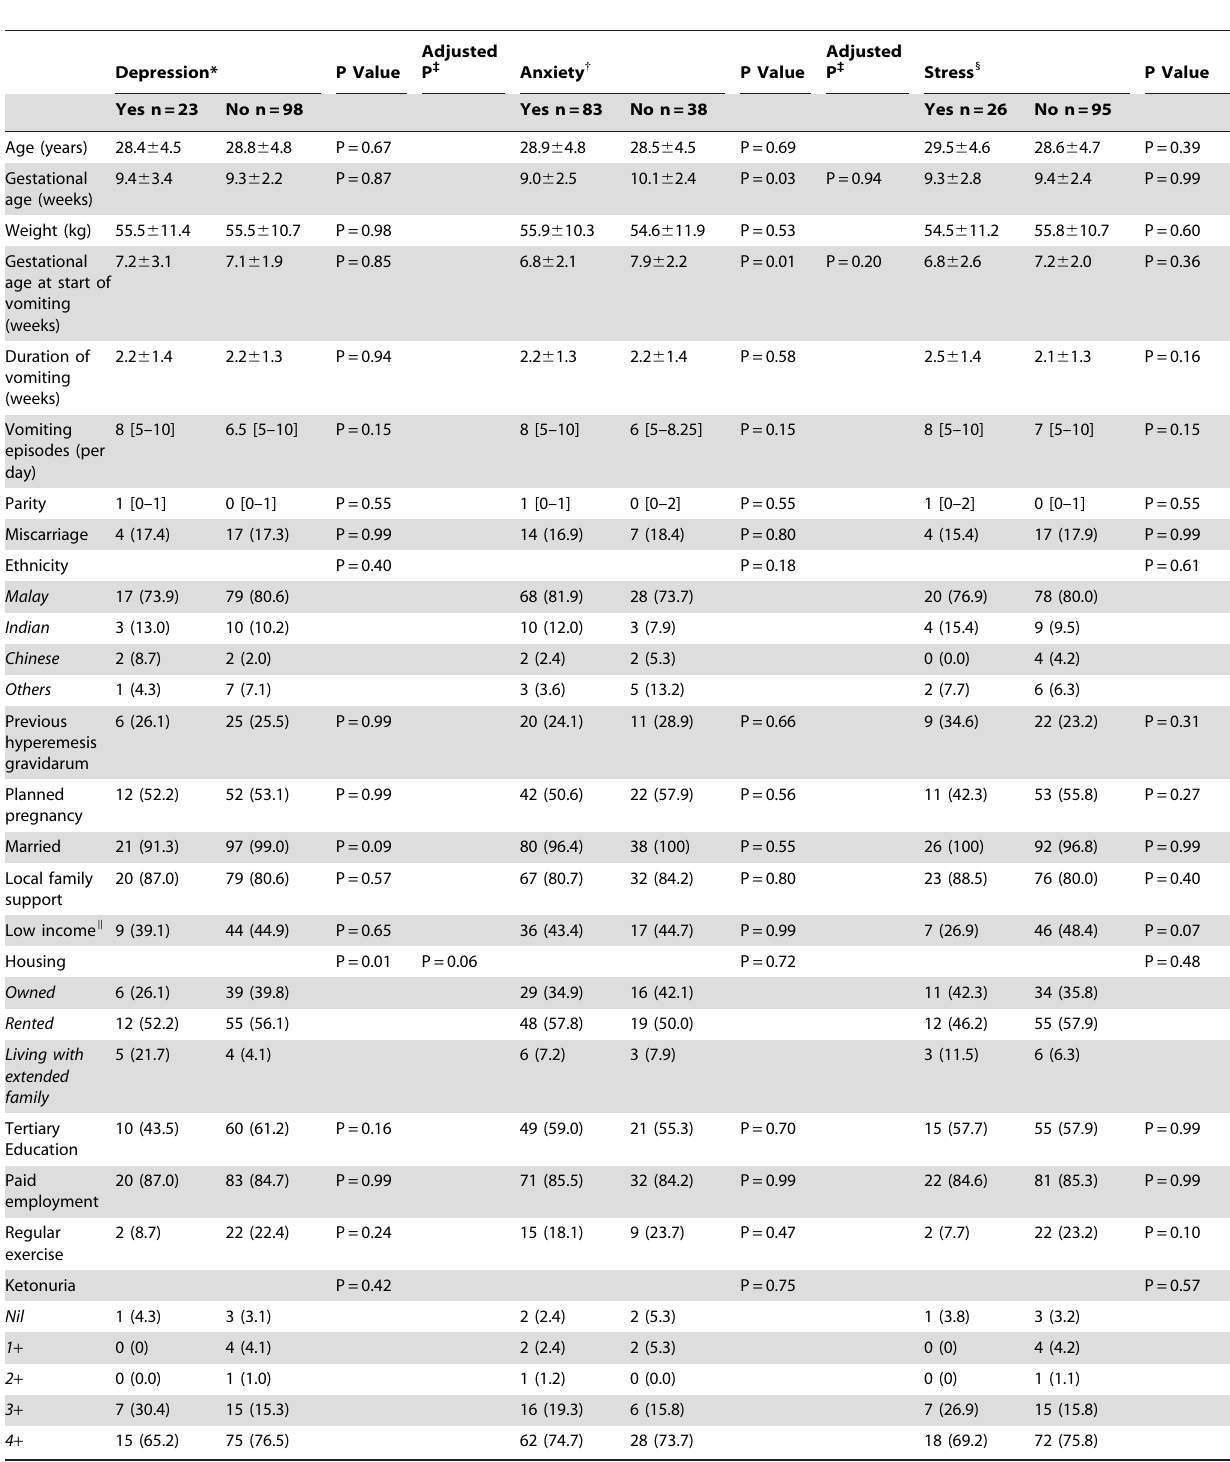
Table 1. Characteristics of women with hyperemesis gravidarum at hospitalization stratified according to their depression, anxiety and stress status as assessed by the 21-stem Depression Anxiety and Stress